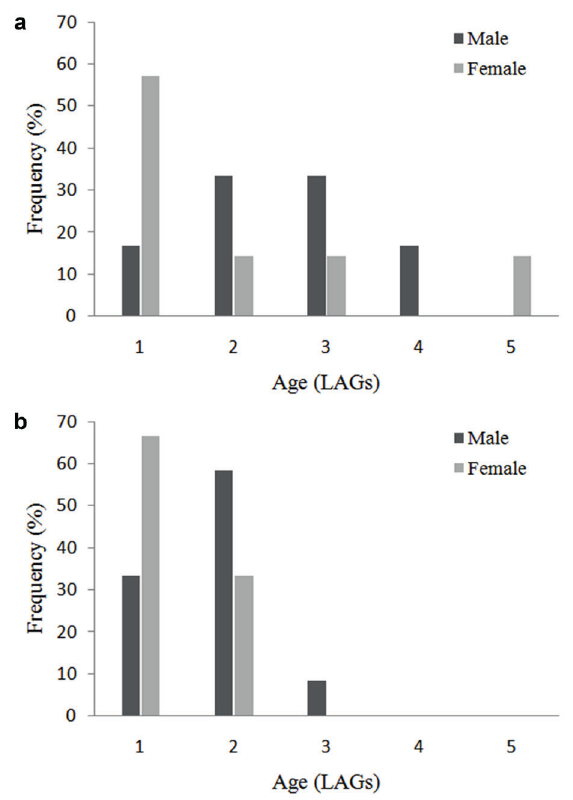
Figure 3 - Population age structure in males and females of L. bufonius ( a ) and L. latinasus ( b